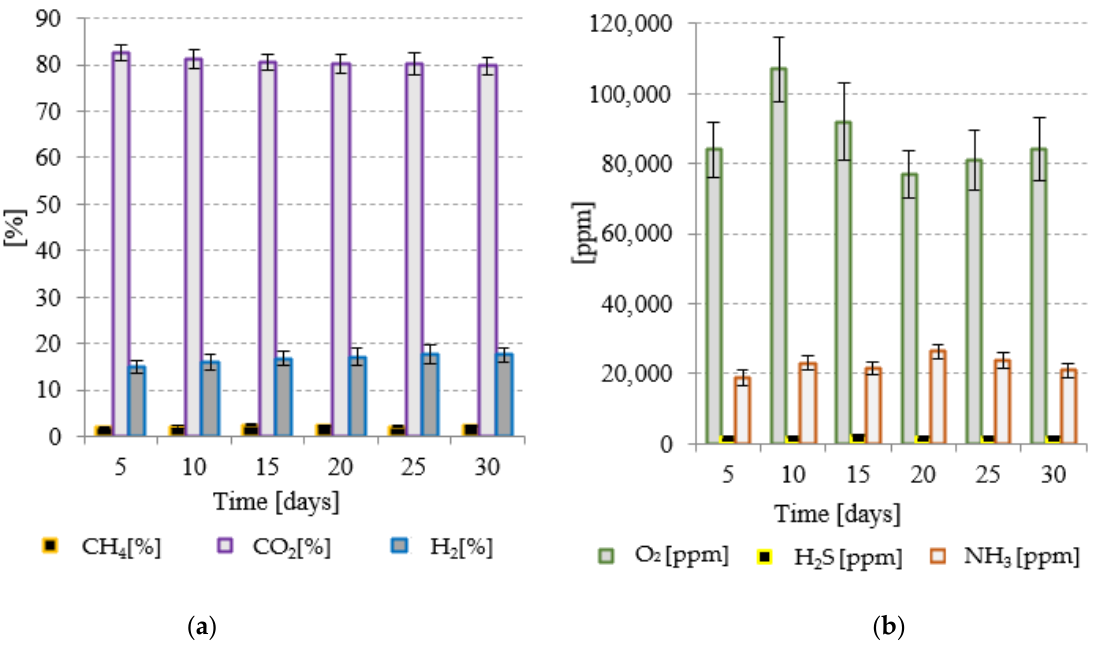
Figure 2. Biogas fractions ( a ) CH 4 , CO 2 , and H 2 , ( b ) O 2 , H 2 S, and NH 3. Alvarez-Guzmán et al. (2020) were one of the few to examine whether psychrophilic bacteria can be used for fermentative hydrogen production from organic waste. Using the psychrophilic bacterium GA0F, the researchers obtained 73.5 ± 10 cm 3 H 2 /g from whey powder, 43.6 ± 2 cm 3 H 2 /g from wheat straw hydrolysate, and 52.4 ± 4 cm 3 H 2 /g from cane molasses [45]. Zieli´nski et al. (2017) have tested the utility of psychrophilic bacteria from the phyla Proteobacteria ( Rahnella aquatilis , Raoutella terrigena ) and Firmicutes ( Carnobac- terium maltaromaticum , Clostridium algidixylanolyticum ) with regard to